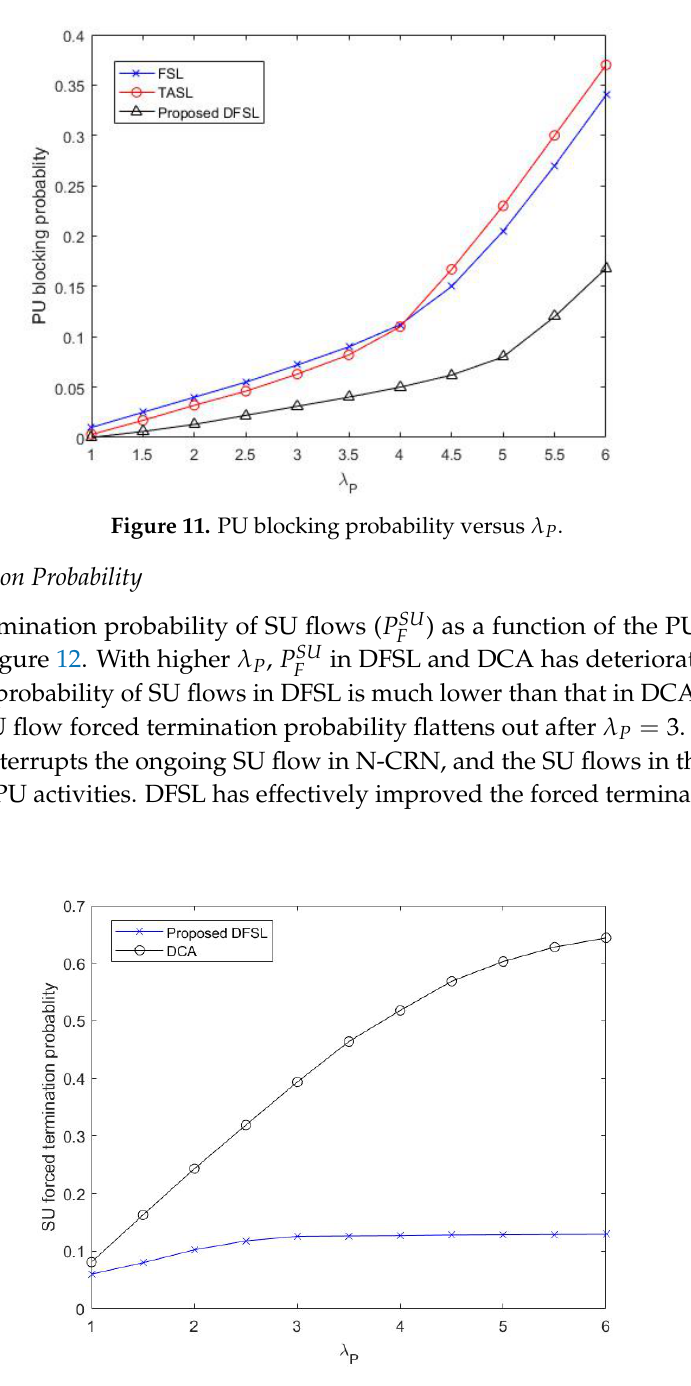
Figure 12. SU forced termination probability with λ P